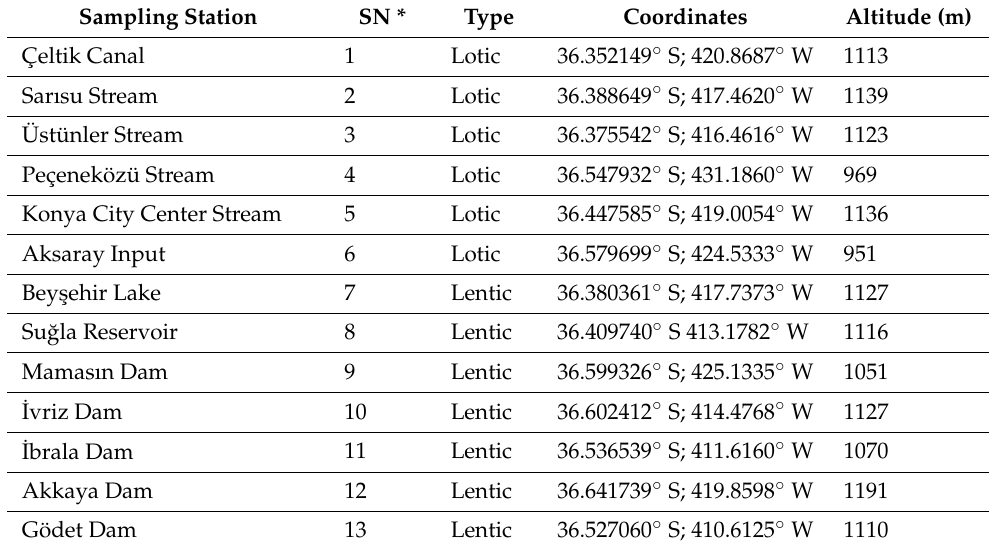
Table 1. Sampling stations in KCB.